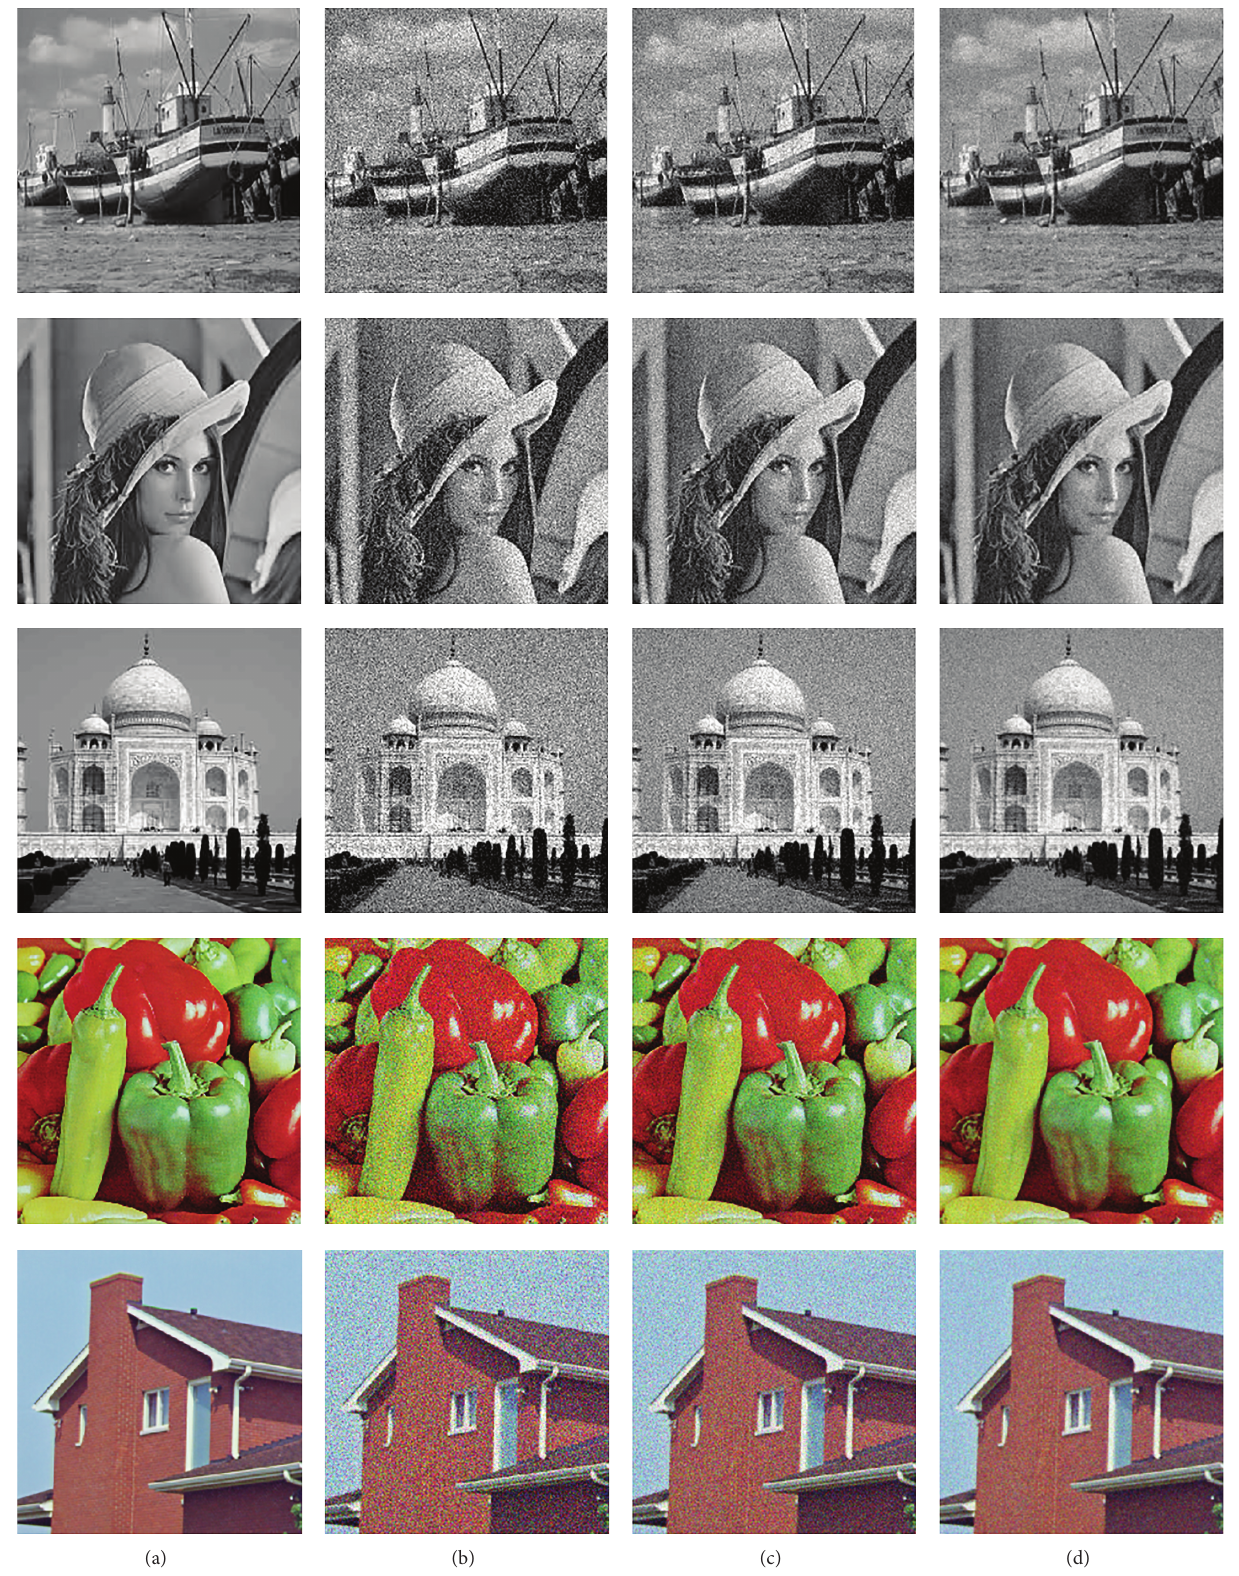
Figure 6: Denoising results, (a) original image, (b) corrupted image with additive white Gaussian noise with 𝜎 value of 25, (c) Gaussian smoothing filter, and (d) FHD